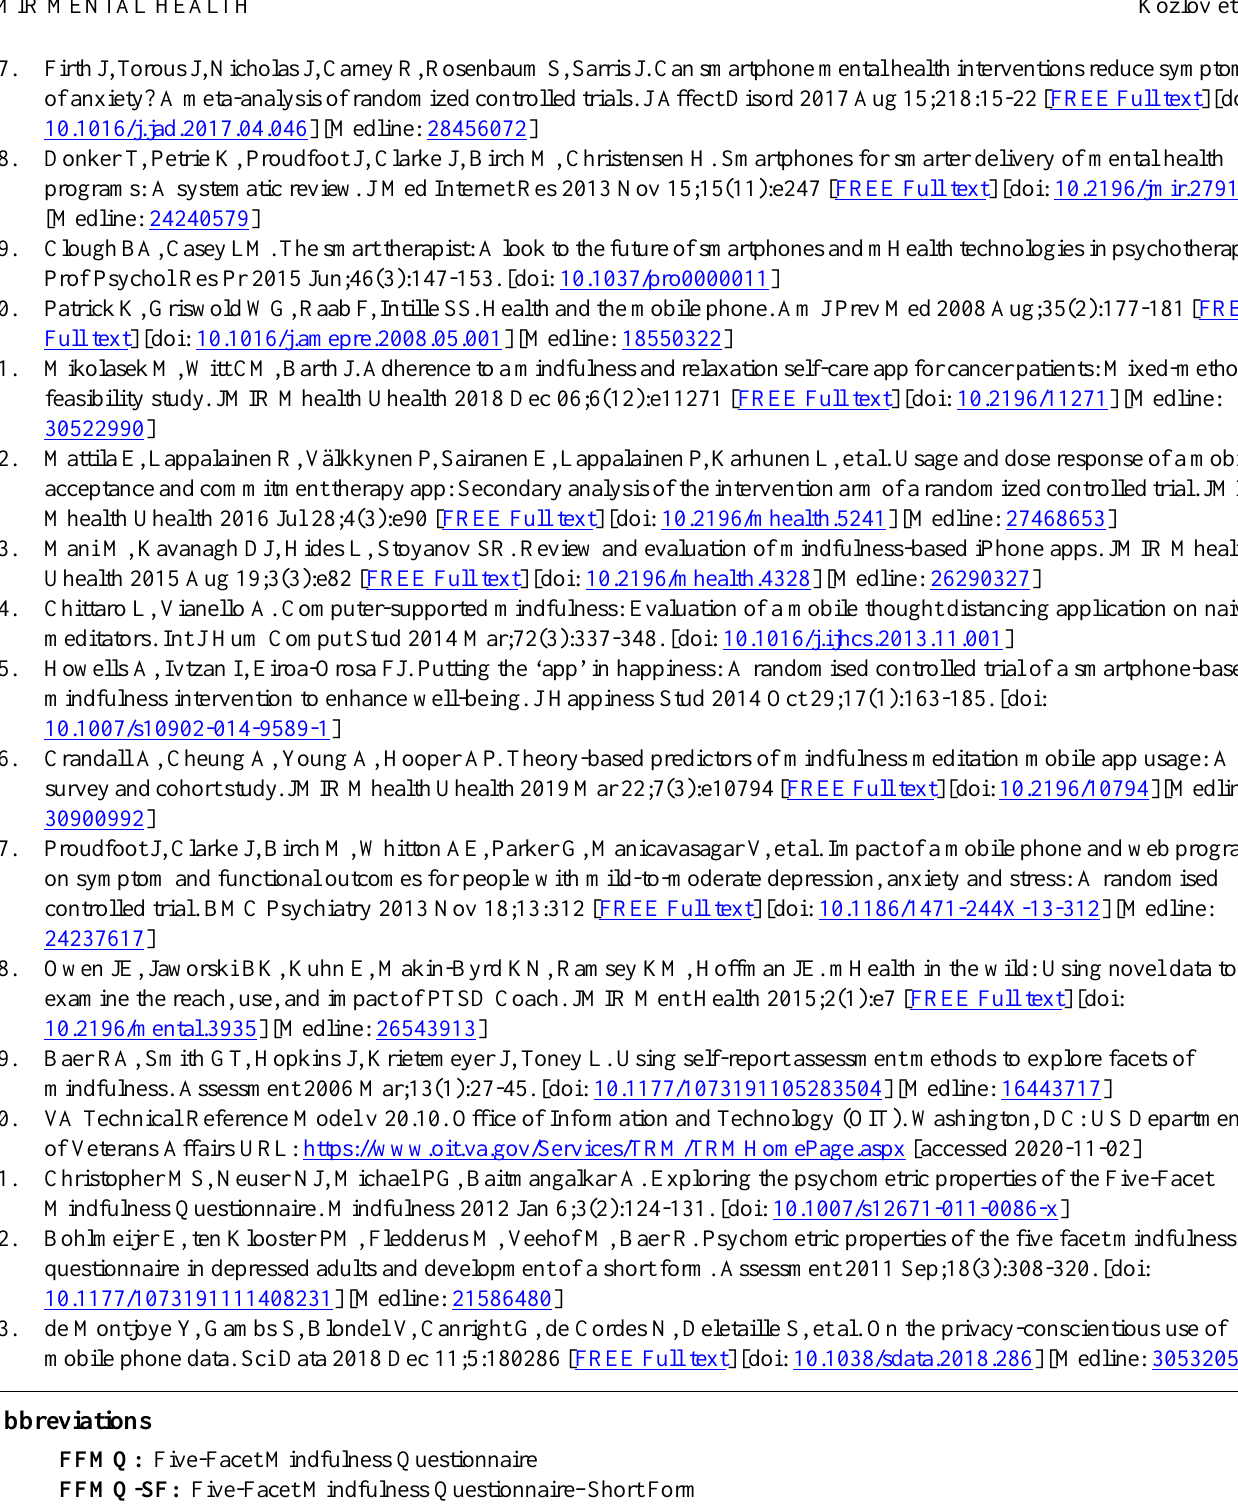
FFMQ: Five-Facet Mindfulness Questionnaire FFMQ-SF: Five-Facet Mindfulness Questionnaire–Short